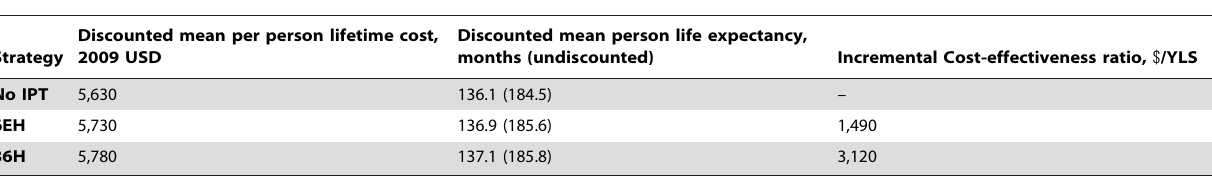
Table 5. Incremental cost-effectiveness of TB preventive therapy for HIV-infected individuals in India.